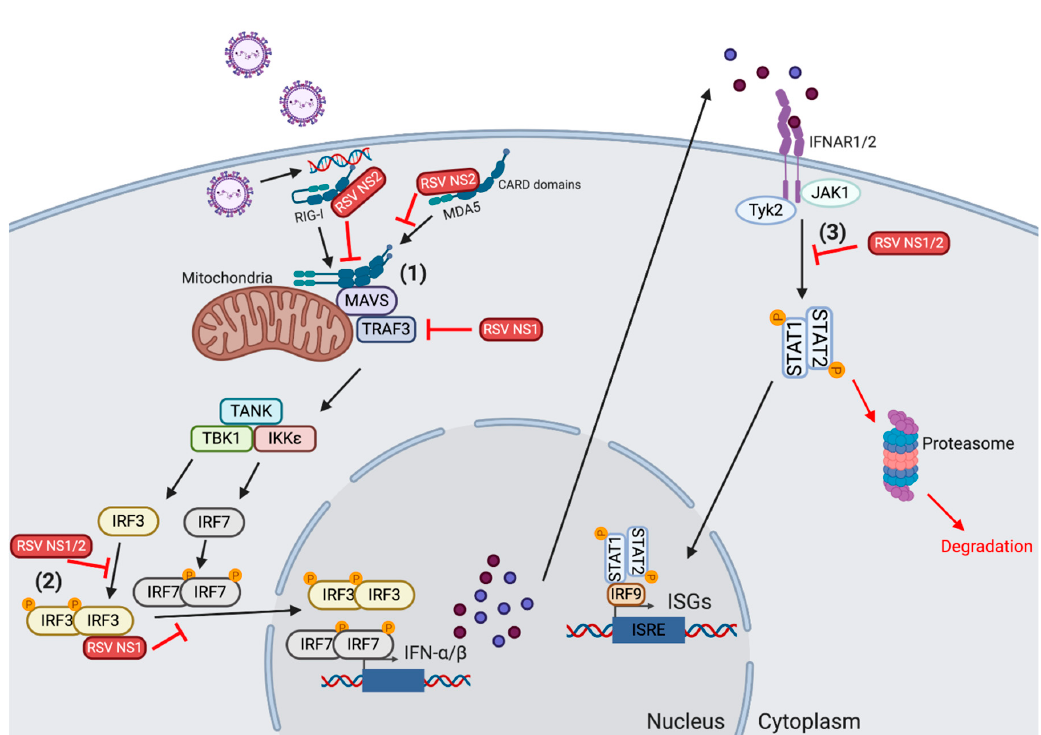
Figure 1. Mechanisms for respiratory syncytial virus (RSV) inhibition of type I interferon (IFN) production. ( 1 ) The RSV NS1 and NS2 proteins can act on many components of the type I IFN induction pathway in order to reduce the production of IFN- α / β . NS2 binds to the caspase activation and recruitment domains (CARDs) on retinoic acid-inducible gene-I-like receptor (RIG-I) and melanoma differentiation-associated protein 5 (MDA5). This blocks RIG-I from dimerizing and interacting with mitochondrial antiviral signaling (MAVS). NS1 also reduces the level of TNF receptor-associated factor (TRAF)3 inside the cell, inhibiting the subsequent activation of the downstream TANK-binding kinase 1 (TBK1)/I κ B kinase (IKK ε ) complex. ( 2 ) Both NS1 and NS2 block the translocation of interferon regulatory factor (IRF)3/IRF7 into the nucleus. NS1 can bind and sequester IRF3 in the cytosol. NS1 and NS2 both inhibit the upstream phosphorylation of IRF3. ( 3 ) NS1 and NS2 also act on the IFN receptor (IFNAR) signaling pathway to obstruct the induction of type I IFN-mediated interferon-stimulating gene (ISG) production. NS2 reduces the levels of both total signal transducer and activator of transcription (STAT)2 and phoshorylated STAT2. The dimished activation inhibits the nuclear translocation of STAT1/STAT2, reducing the induction of ISGs. Finally, the presence of NS1 lowers the quantity of ISGs found in infected cells. Created with BioRender.com